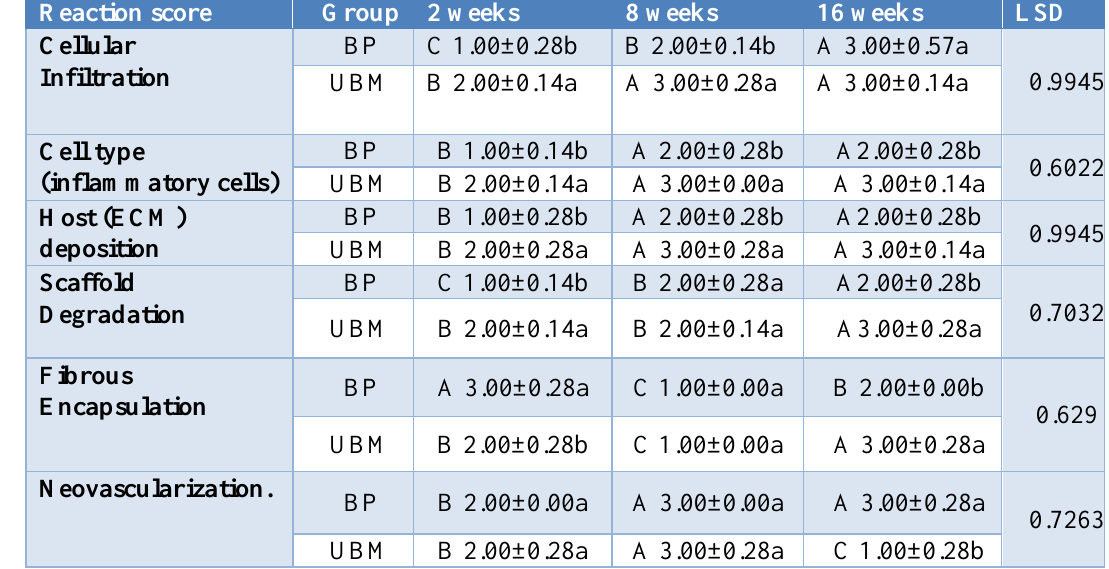
Table ,2 : Shows the Means± SE of histopathological score results for both treatment